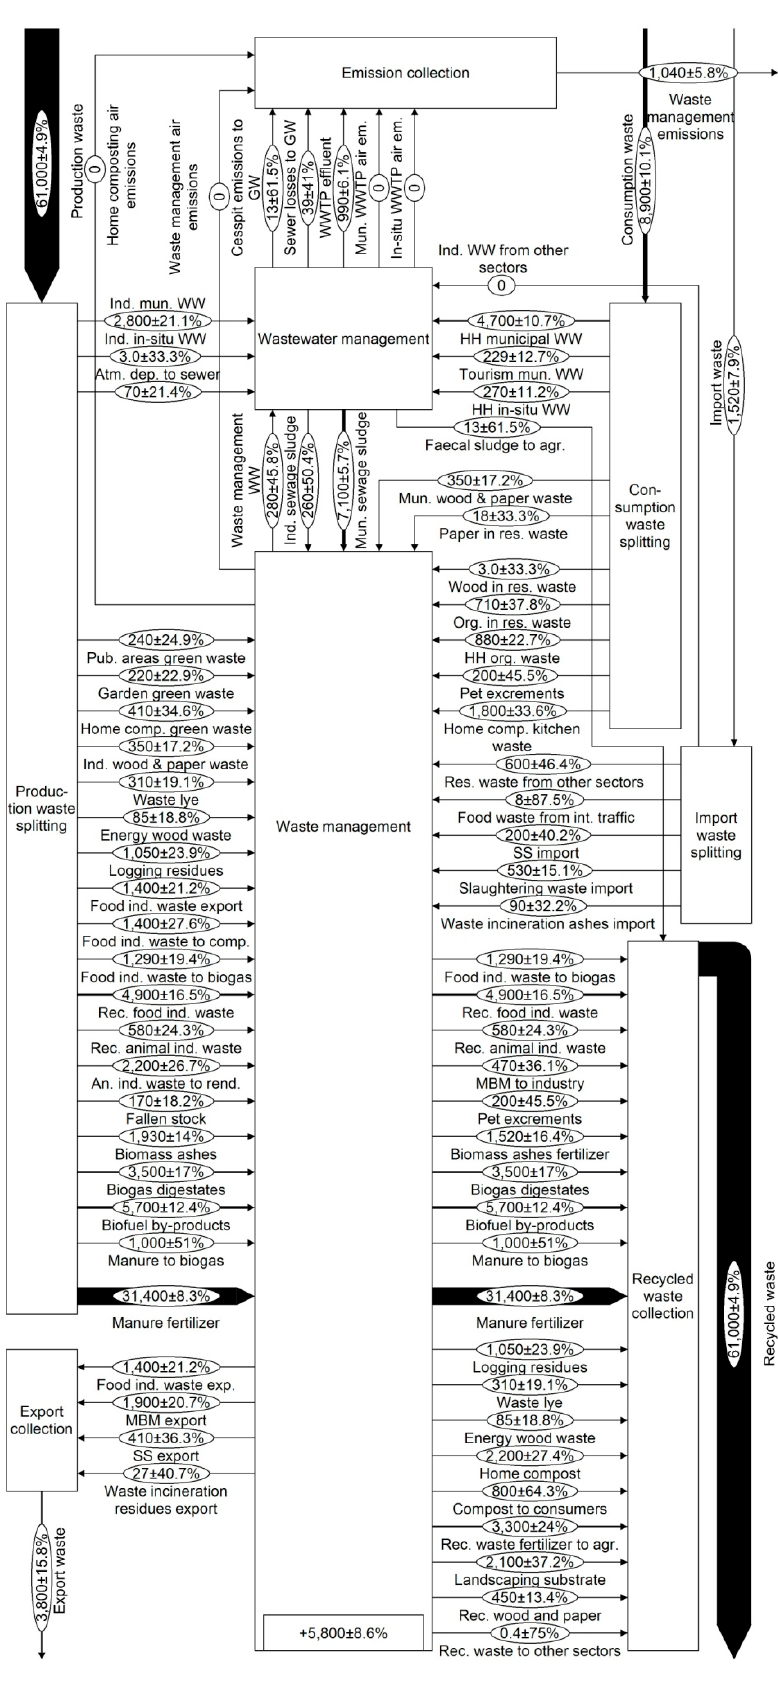
Figure A3. Austrian P system 2015, subsystem waste management.